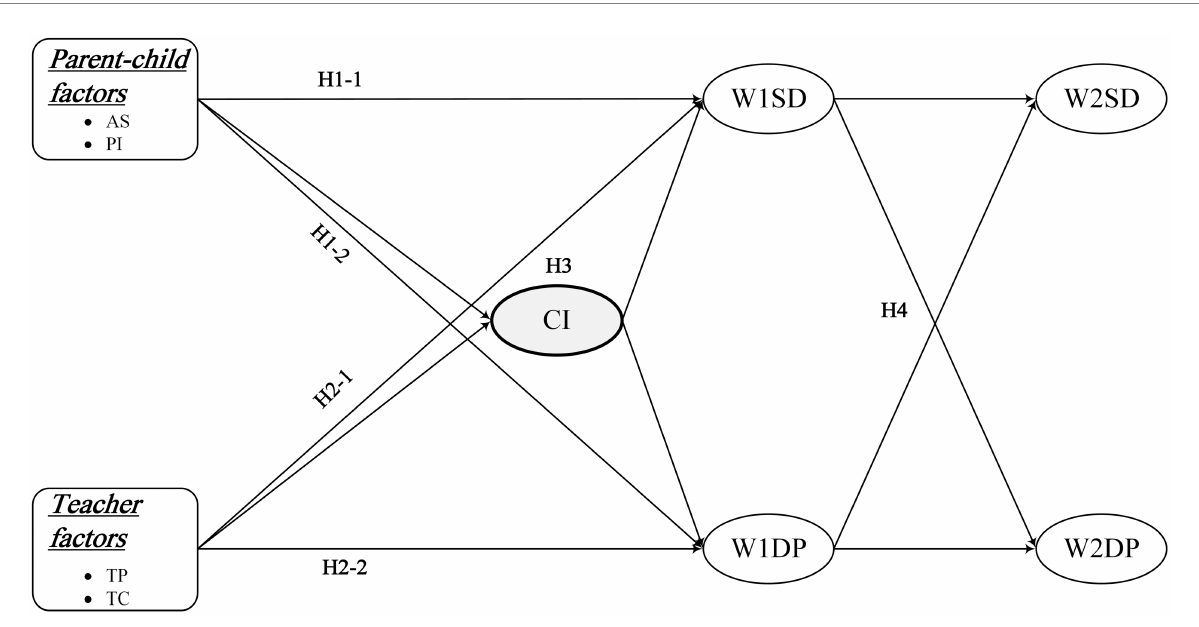
FIGURE 1 Hypothesized model of the research framework. AS, Academic Self-efficacy; PI, Parental Involvement; TP, Teacher Praise; TC, Teacher Criticism; CI, Collective Integration; W1SD, Sleep Duration in 2013–2014; W1DP, Depression in 2013–2014; W2SD, Sleep Duration in 2014–2015; W2DP, Depression in 2014–2015. Hypotheses were that (H1-1) academic self-efficacy and parental involvement would be positively correlated with sleep duration; (H1-2) academic self-efficacy and parental involvement would be negatively correlated with depression; (H2-1) teacher Praise would be positively correlated with sleep duration, whereas teacher criticism would be negatively correlated with sleep duration; (H2-2) Teacher Praise would be negatively correlated with depression, whereas teacher criticism would be positively correlated with depression; (H3) collective integration would mediate the relationships of parent–child factors and teacher factors with sleep duration and depression; and (H4) there would be a cross effect between sleep duration and